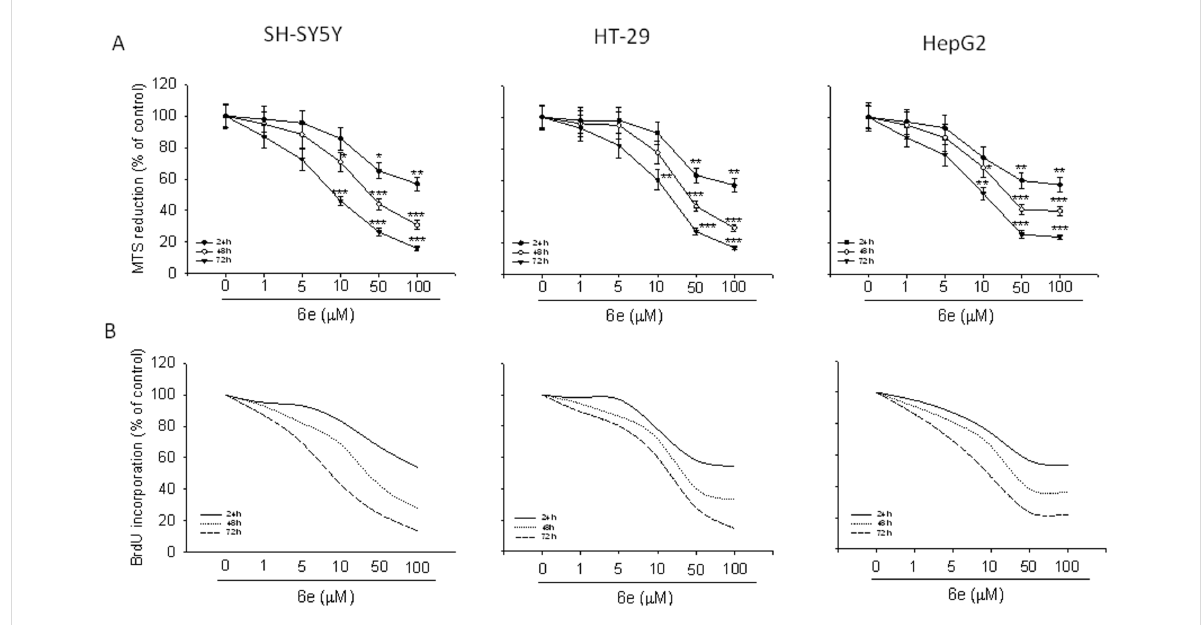
Figure 7: Compound 6e reduces cancer cell proliferation. Treatment of SH-SY5Y, HT-29 and HepG2 cells with 6e in a range from 1 to 100 µM for 24, 48 and 72 h reduced the growth rate in a time and concentration-dependent manner. The experiments were performed by the MTS assay (a) and BrdU test (b). Results are expressed as percentages of growth rates of treated cells compared to untreated cultures, and are the means ± SEM from of independent experiments performed in eightplicate (MTS assay) or in triplicate (BrdU test). * P < 0.05, ** P < 0.01 and *** P < 0.001 vs untreated